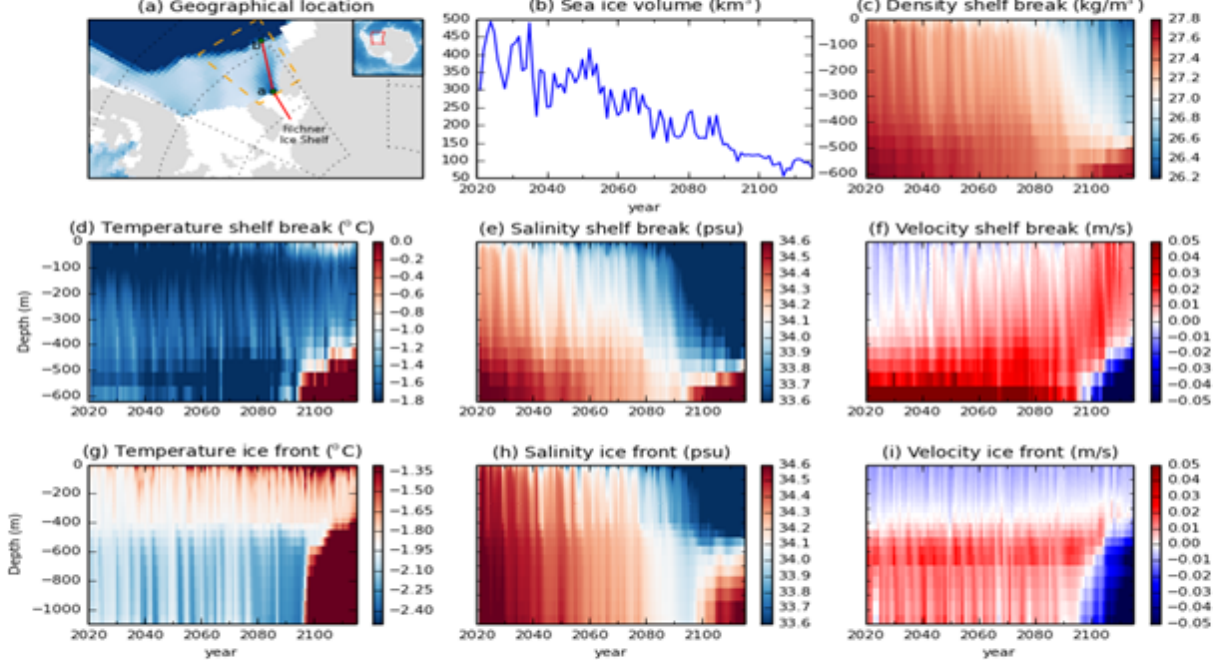
Figure 8. Filchner Trough profiles in the SSP5–8.5 scenario. (a) The chosen section on the Filchner Trough is indicated by the red line segment between green dots a and b. The entire red line denotes the meridional section used in Fig. 9. The dark- and light-blue colours represent the deep ocean and the continental shelf in the Weddell Sea, respectively, whereas the grey and white colours represent the grounded ice sheet and the Filchner–Ronne Ice Shelf, respectively. (b) Sea ice volume on the area enclosed by the orange dashed lines in (a) . (c–f) The time series of potential density, temperature, salinity and meridional velocity, respectively, at the shelf break indicated by green dot b in (a) . (g–i) The time series of temperature, salinity and meridional velocity at the ice front indicated by green dot a in (a)